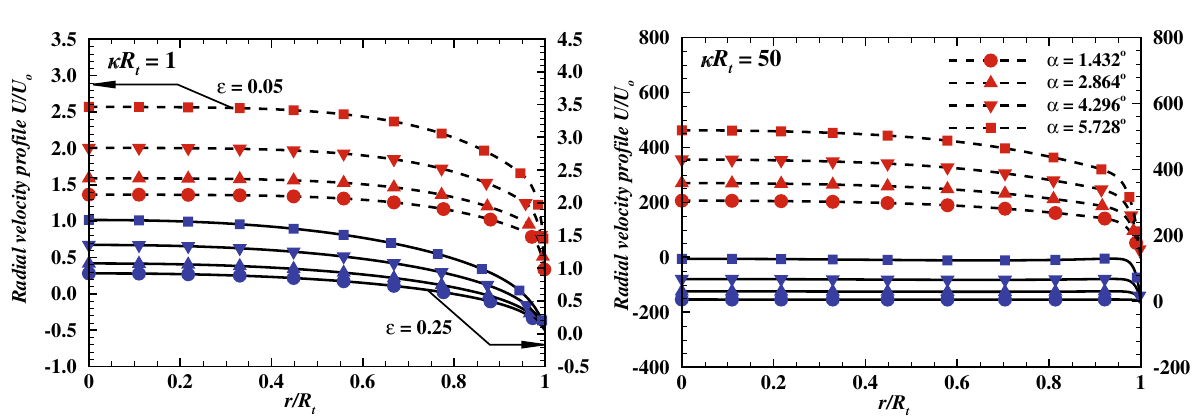
Figure 7. Radial velocity variation with α at ǫ = 0.05 (red symbols) and ǫ = 0.25 (blue symbols), V = 40, De = 100 and σ = − 50 and for two extreme values of κ R t